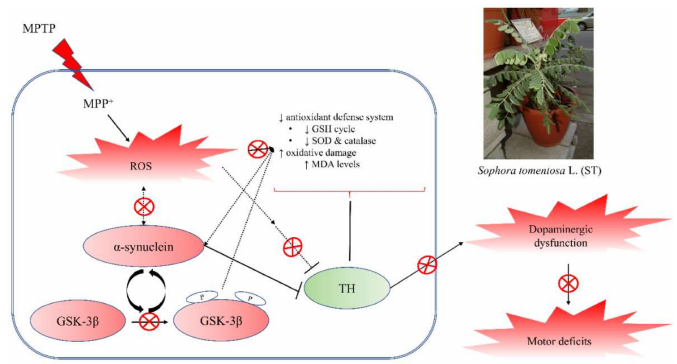
Figure 8. The biological action of Sophora tomentosa (ST) as a potential neuroprotective plant against an MPTP-induced PD mouse model. GSH: glutathione, MDA: malondialdehyde, MPTP: 1-methyl-4-phenyl-1,2,3,6-tetrahydropyridine, PD: Parkinson’s disease, ROS: reactive oxygen species, SOD: superoxide dismutase, ST: Sophora tomentosa , TH: tyrosine